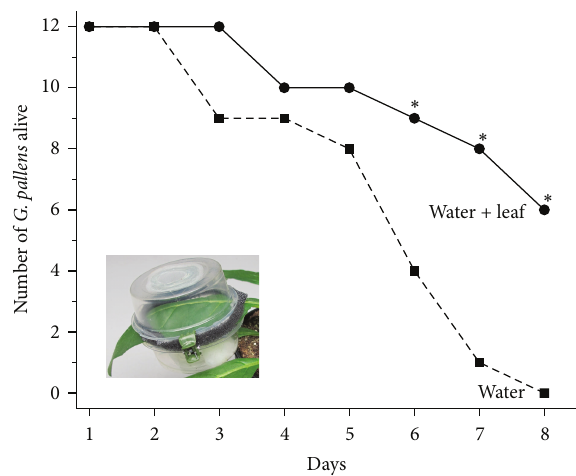
Figure 8: Use of N. attenuata leaf tissue as a food source by G. pal- lens . The graph shows the number of G. pallens individuals surviving in clip cages with either a cotton ball soaked with water (water) or water plus an N. attenuata leaf still attached to a living plant (water + leaf). Inset: clip cage on a leaf with a moist cotton ball in the lower right (water + leaf treatment); each half of the cage has a hole covered with netting to permit transpiration (only visible for top half). Asterisks indicate significant differences between treatments obtained by Fisher’s exact tests on indicated days, 𝑃 < 0.05